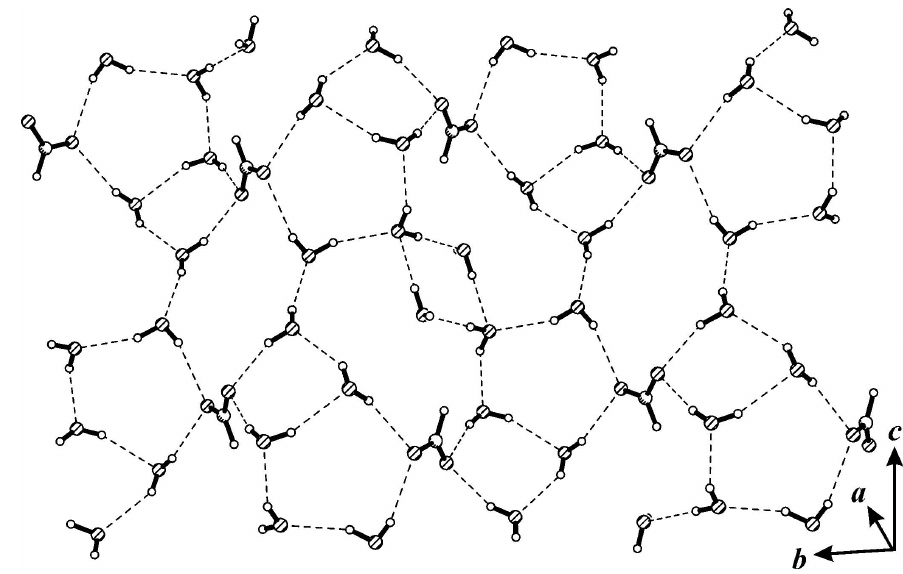
The two-dimensional water-formate anion